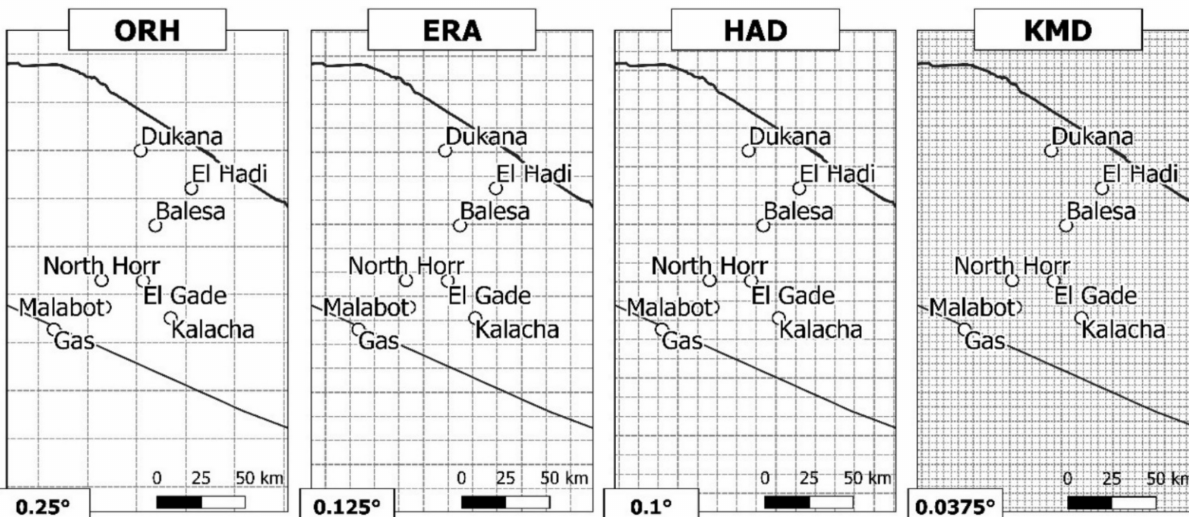
Figure 3. Comparison of the different resolutions of the gridded dataset. The ten-day dataset from the Kenyan Meteorologi- cal Department (KMD) has the highest resolution (0.0375 ◦ ) followed by the Climate Limited Area Model (CCLM) driven by HadGEM2-ES (HAD), with a spatial resolution of 0.1 ◦ , the ERA-Interim Reanalysis (ERA), with a spatial resolution of 0.125 ◦ and then by the Observation Reanalysis Hybrid (ORH), with the broader spatial resolution (0.25 ◦